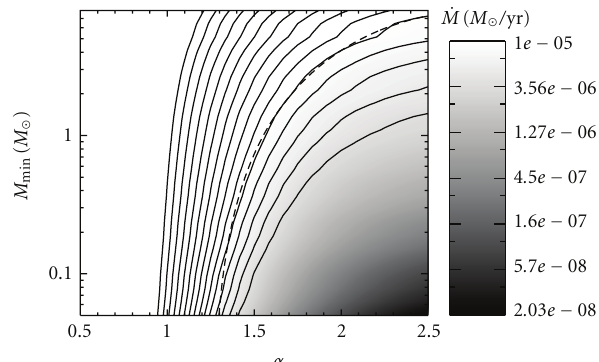
Figure 13: The total mass loss rate contributing the 2–10 keV flux (calculated from (26)) as a function of M min and α . The solid contours are on a logarithmic scale and are limited from above at 10 − 5 M (cid:5) yr − 1 . The line contours are on a linear scale and are separated by intervals of 1 . 5 × 10 − 6 M (cid:5) yr − 1 . The thick line denotes the 1 × 10 − 5 M (cid:5) yr − 1 contour. The dashed line is a 3rd-order polynomial fit which represents the absolute allowed upper limit of M min as a function of α . The coe ffi cients of this polynomial are 21.71, − 42.37, 25.33, and − 4.27 for a 0 to a 3 , respectively.